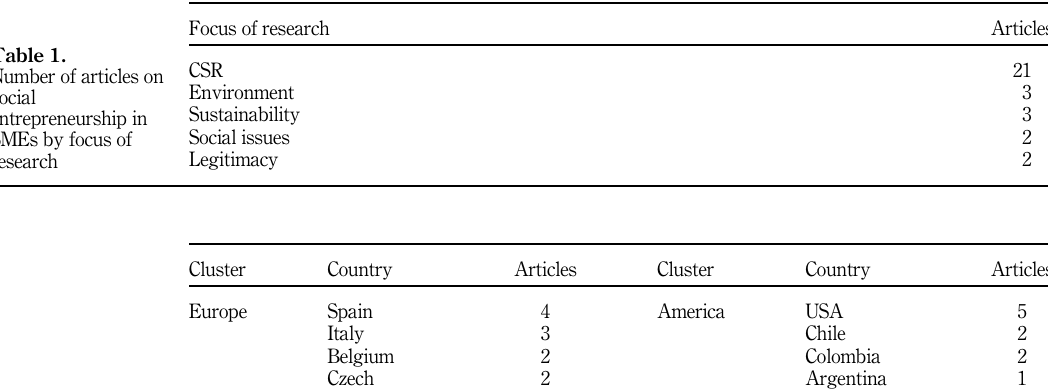
country and present them in Table 2. Notably, from 31 articles that we analyzed, USA (5 times) and Spain (4 times) were the most studied contexts. Finally, we sorted the number of articles by main theories and present them in Table 3. Stakeholder theory (7 times), institutional theory (3 times) and social capital theory (3 times) were the most popular theories that scholars adopted in these studies. We also note that while surveys (14 times) and interviews (14 times) were the most conducted empirical methods, case studies (7 times) and secondary datasets (5 times) were also implemented. Various secondary datasets were also